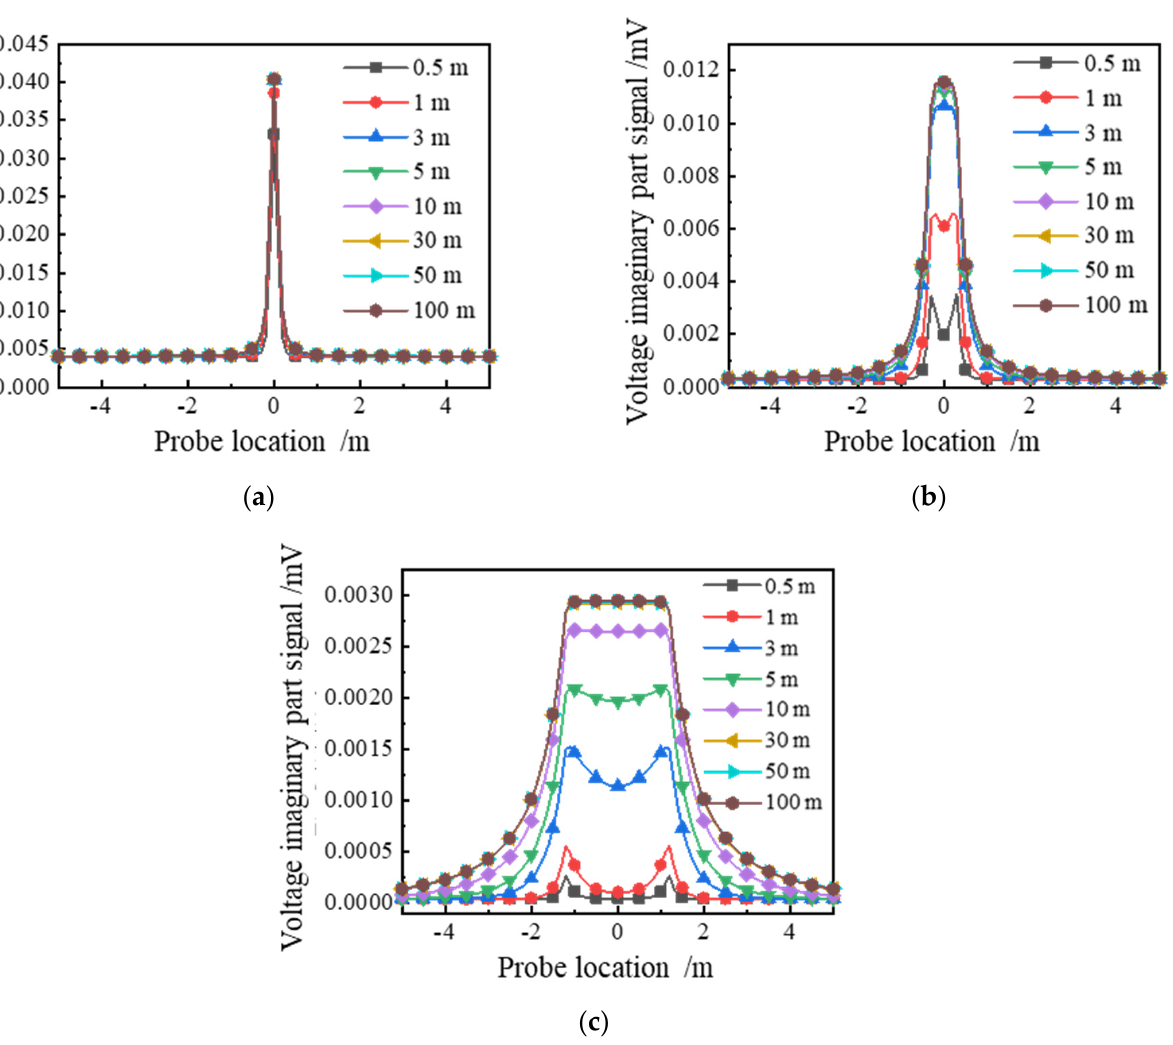
Figure 11. The voltage real part signal curves of circular fractures with different sizes: ( a ) real part signal of subarray 1; ( b ) real part signal of subarray 4; ( c ) real part signal of subarray 7.